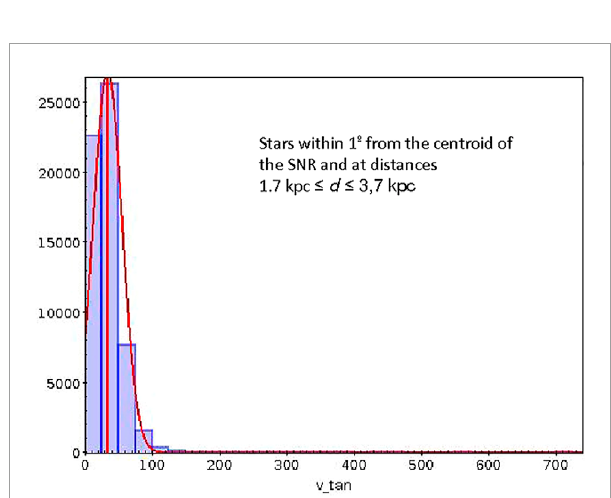
FIGURE 8 Histogram of the distribution of tangential velocities of the stars within 1 degree of the geometrical center of Tycho’s SNR in the range of distance compatible with SN 1572 (1.7 < d < 3.7 kpc). The data are obtained from Gaia DR3 . It can be seen that there are no hypervelocity stars in a very large area around the Tycho’s SN remnant.